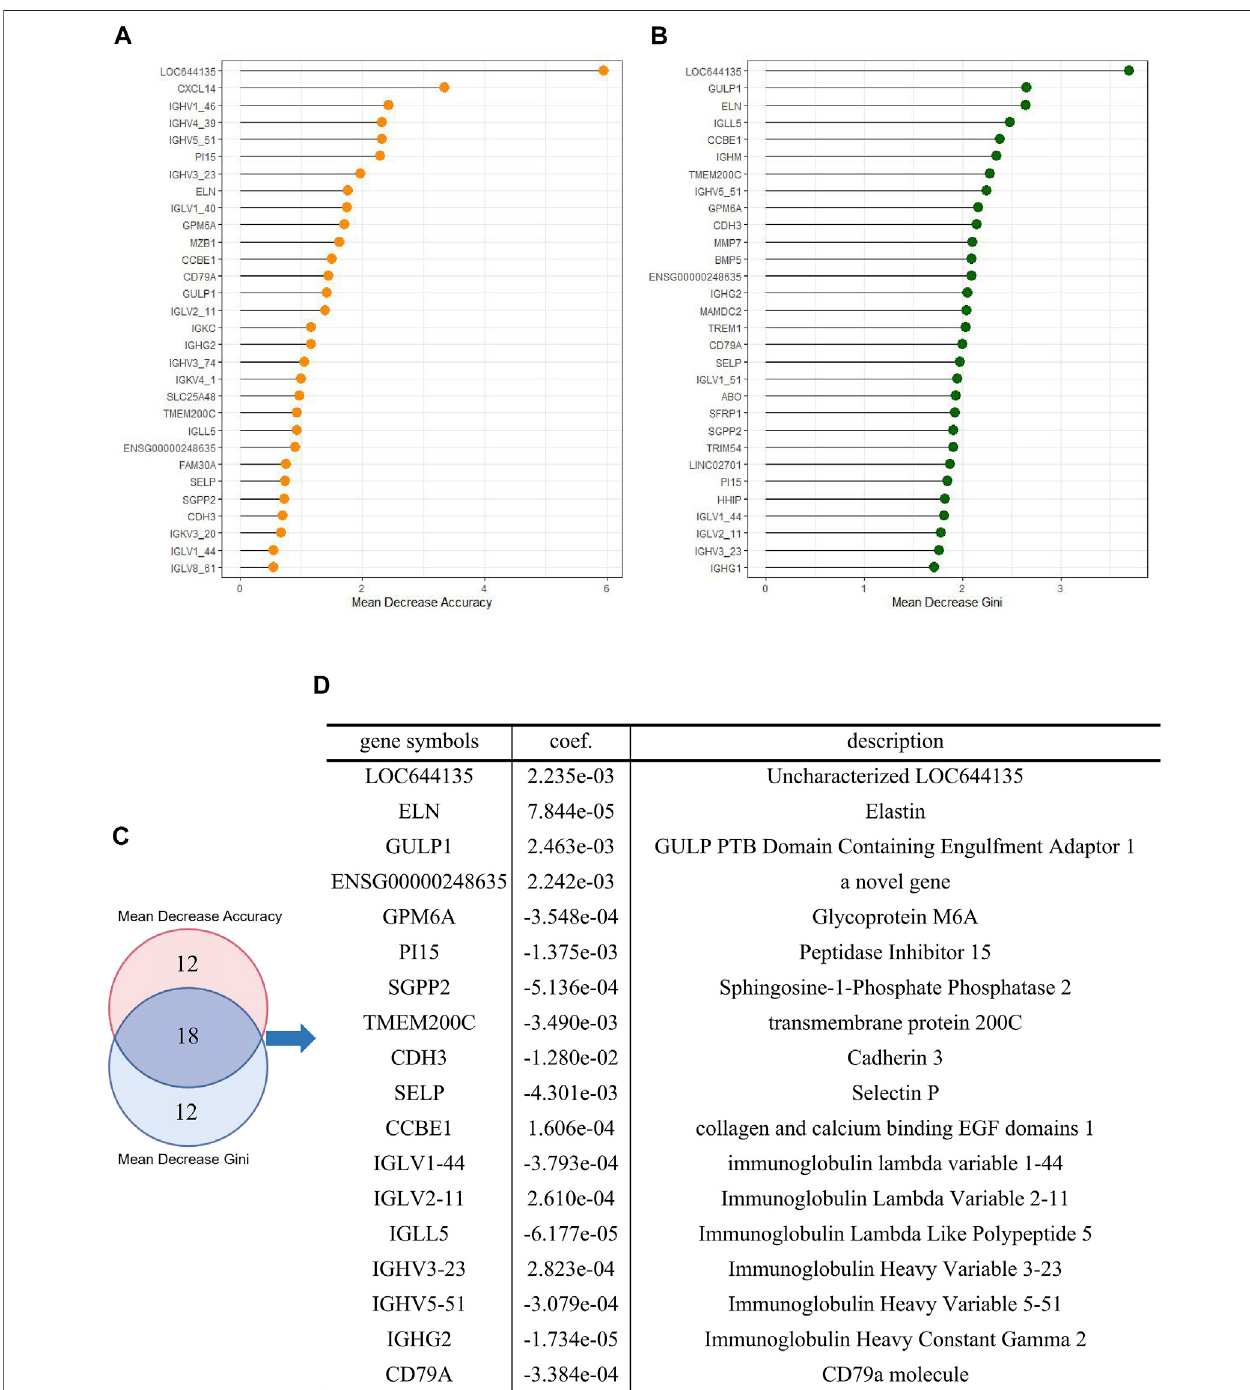
FIGURE 4 | Construction of a risk assessment model (A) Top 30 DE-mRNAs with mean decrease Gini (B) Top 30 DE-mRNAs with mean decrease accuracy (C) Overlapping DE-mRNAs between the selection methods (D) Logistic risk model constructed by overlapping DE-mRNAs.